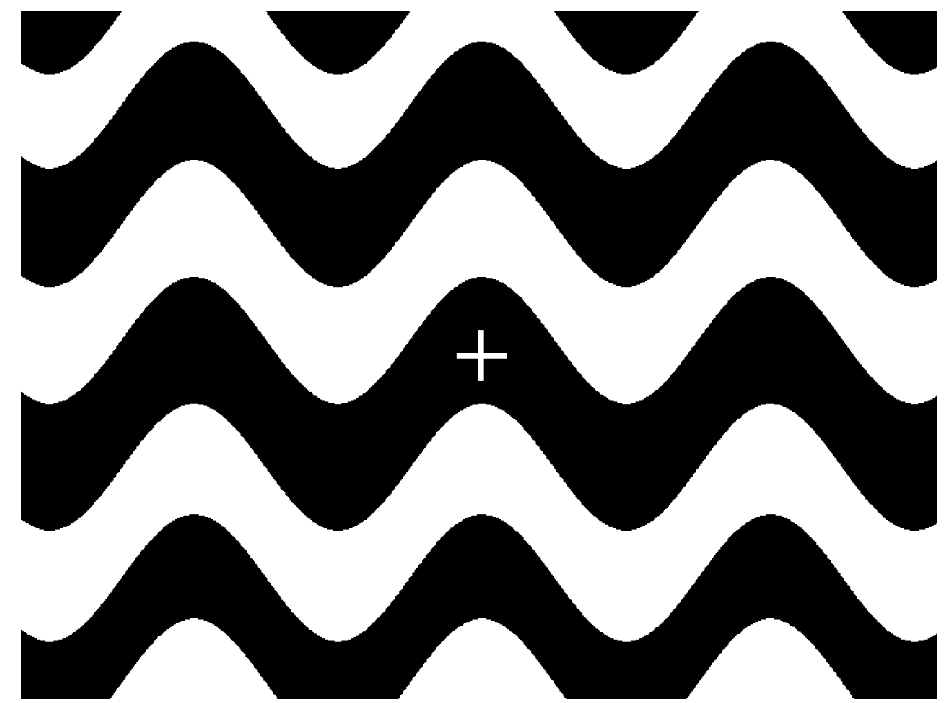
Figure 1a. Example afterimage shapes. For viewing, first enlarge this image, and increase its visual contrast as much as is possible and comfortable. Then, from close by, focus on the crosshair in the middle for about one minute. After this, close your eyes. Briefly, an afterimage will appear. Subsequent blinking may bring it back, as it becomes less and less distinct.